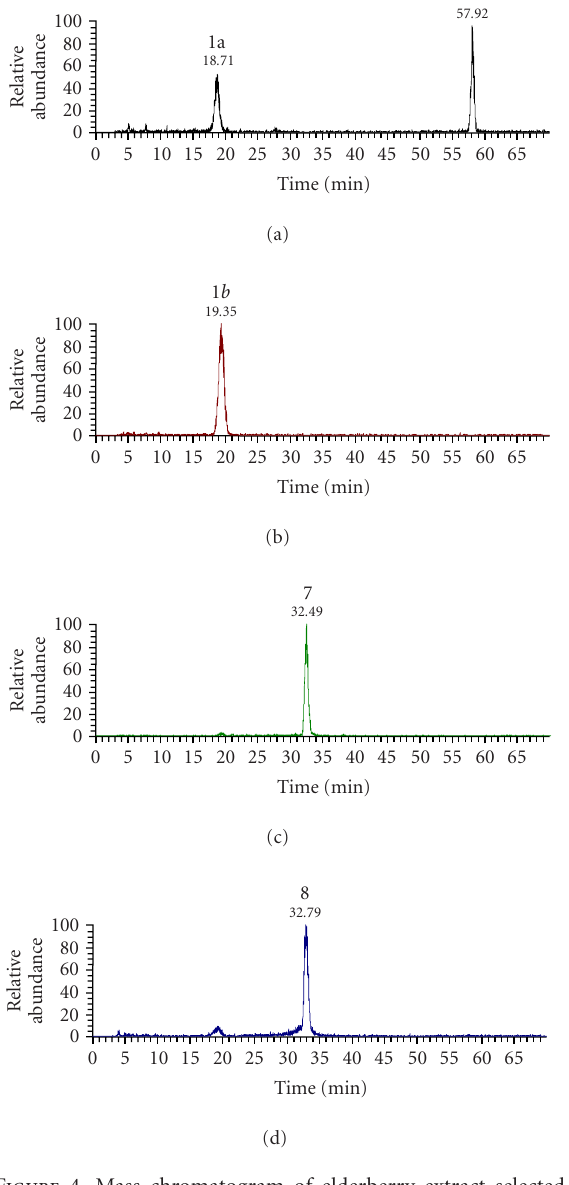
alents per 100 mg of powder after hydrolysis were de- termined as follows: 28.8 mg (bilberry), 24.8 (rabbiteye), 16.0 (black currant), 19.1 (chokeberry), and 30.4